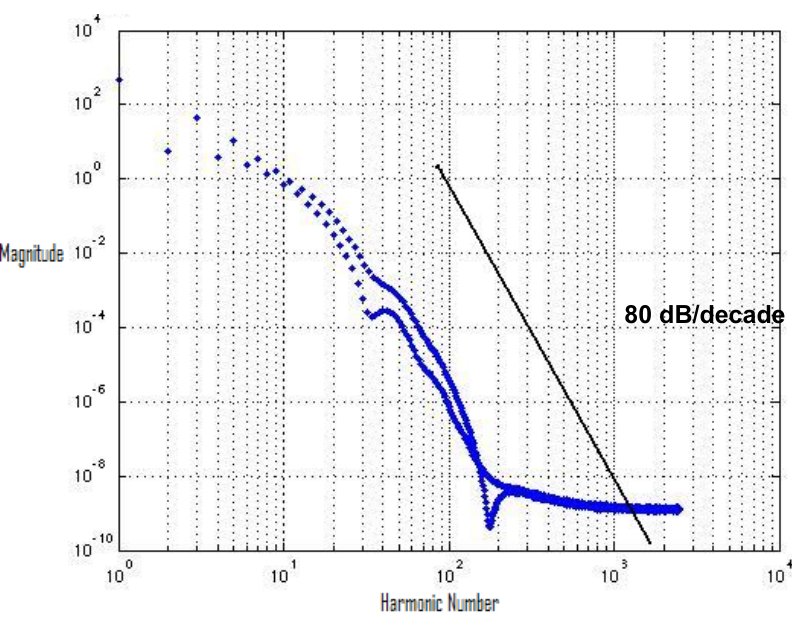
Figure 6. Spectrum plot of the inverter’s switching waveform.